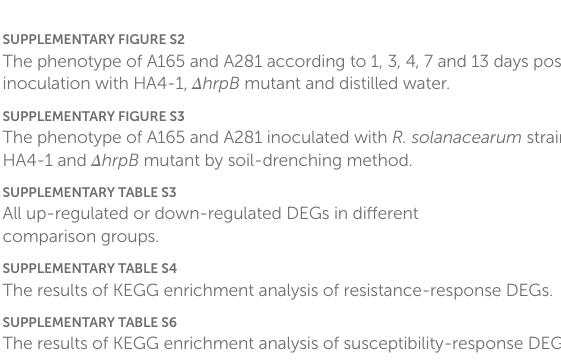
SUPPLEMENTARY TABLE S3 All up-regulated or down-regulated DEGs in different comparison groups. SUPPLEMENTARY TABLE S4 The results of KEGG enrichment analysis of resistance-response DEGs. SUPPLEMENTARY TABLE S6 The results of KEGG enrichment analysis of susceptibility-response DEGs.